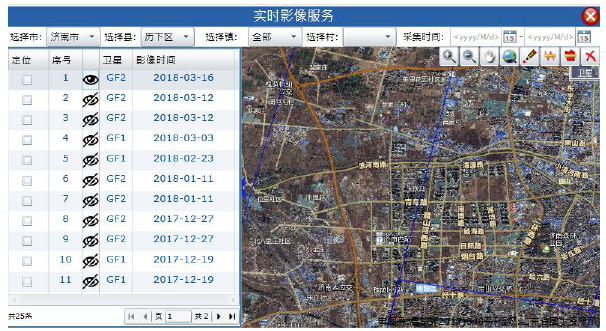
Figure 5. Data query function